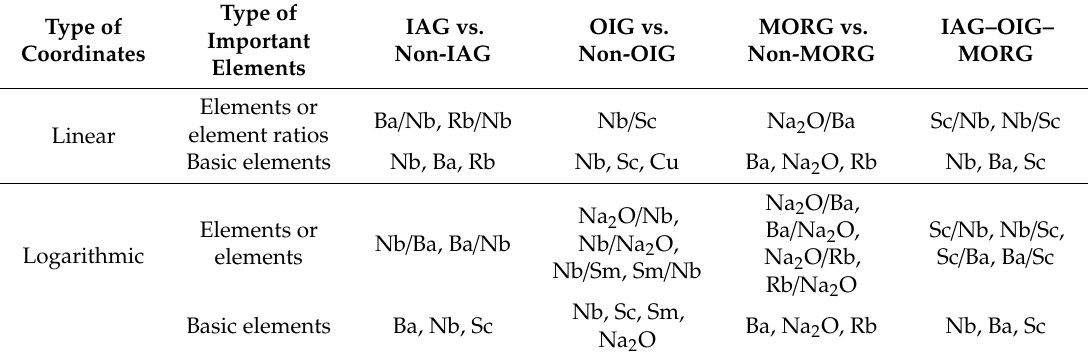
Table 3. Summary of the important elements in di ff erent types of discrimination